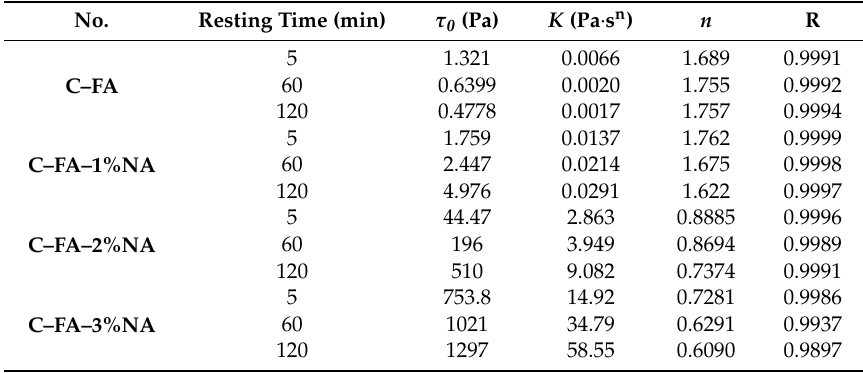
Table 7. Rheological parameters of C–FA paste with NA.